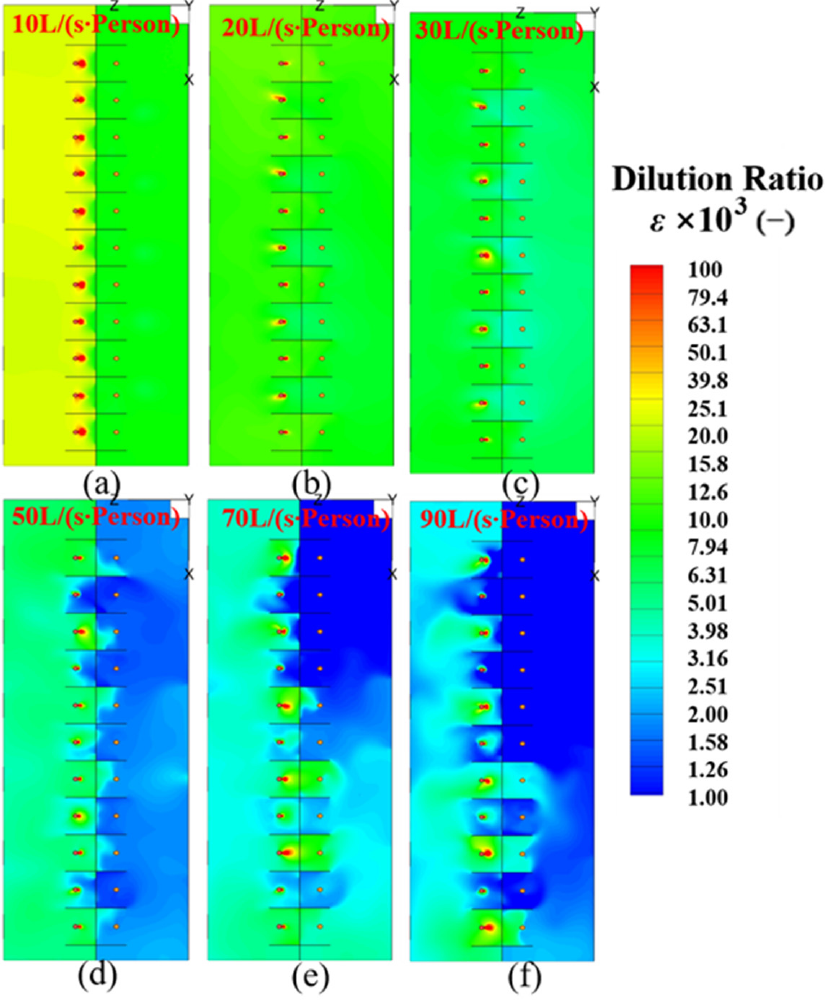
Figure 11. Dilution ratio distribution at the breathing height (y = 1.1 m) under the MEFV with different ventilation rates: ( a ) 10 L/(s · Person); ( b ) 20 L/(s · Person); ( c ) 30 L/(s · Person); ( d ) 50 L/(s · Person); ( e ) 70 L/(s · Person); ( f ) 90 L/(s · Person).